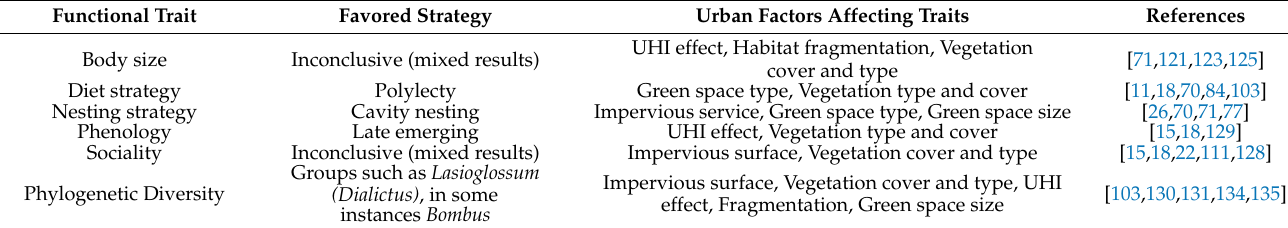
Table 1. Summarization of some of the functional traits affected by some of the varying urban factors presented throughout the